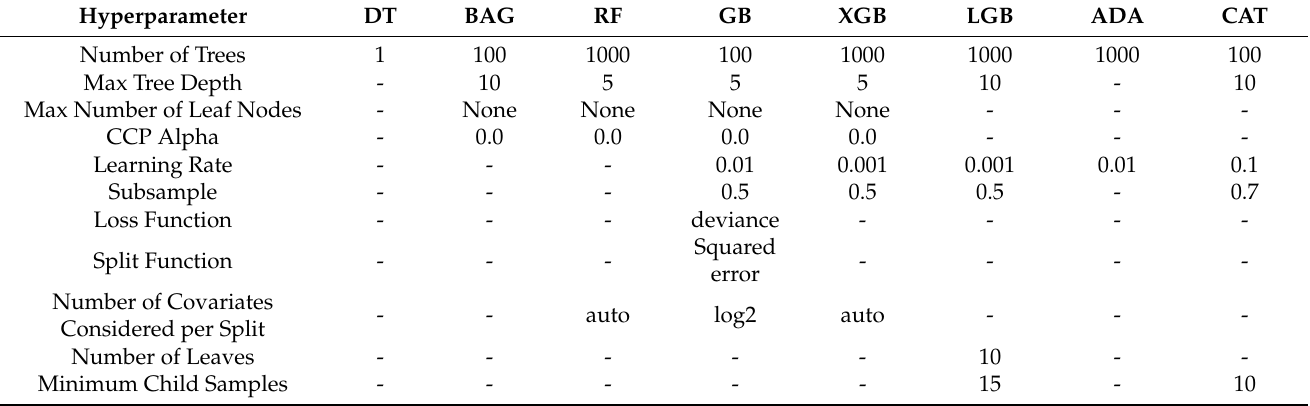
Table 5. Optimal hyperparameters for each binary model after variable selection as determined by grid search.